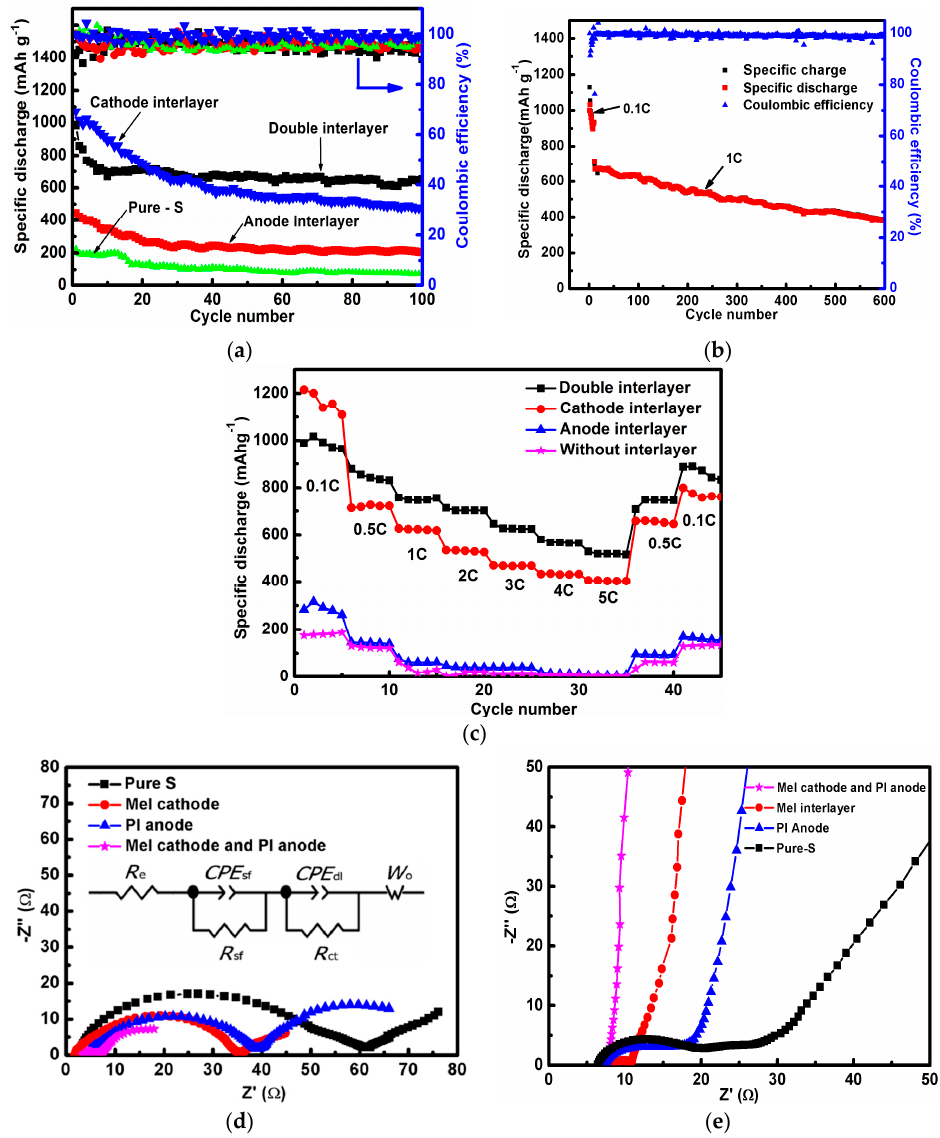
Figure 4. Cycling performance of the cells ( a ) at the rate of 0.1 C; ( b ) at the rate of 1 C, initial 10 cycles is 0.1 C the cycling performance, only for the cell with double interlayer; ( c ) the rate capabilities of the cells with different cell structures; electrochemical impedance spectra under the influence of an AC voltage of 0.1 mV; ( d ) the electrochemical impedance spectrum (EIS) before cycle with the equivalent circuit; electrolyte resistance (R e ), constant phase angle element (CPE), interface impedance (R sf // CEP sf ), reaction impedance (R dl // CEP dl ), semi-infinite diffusion (W o ) ( e ) the EIS after 100 cycles at the rate of 0.1 C.